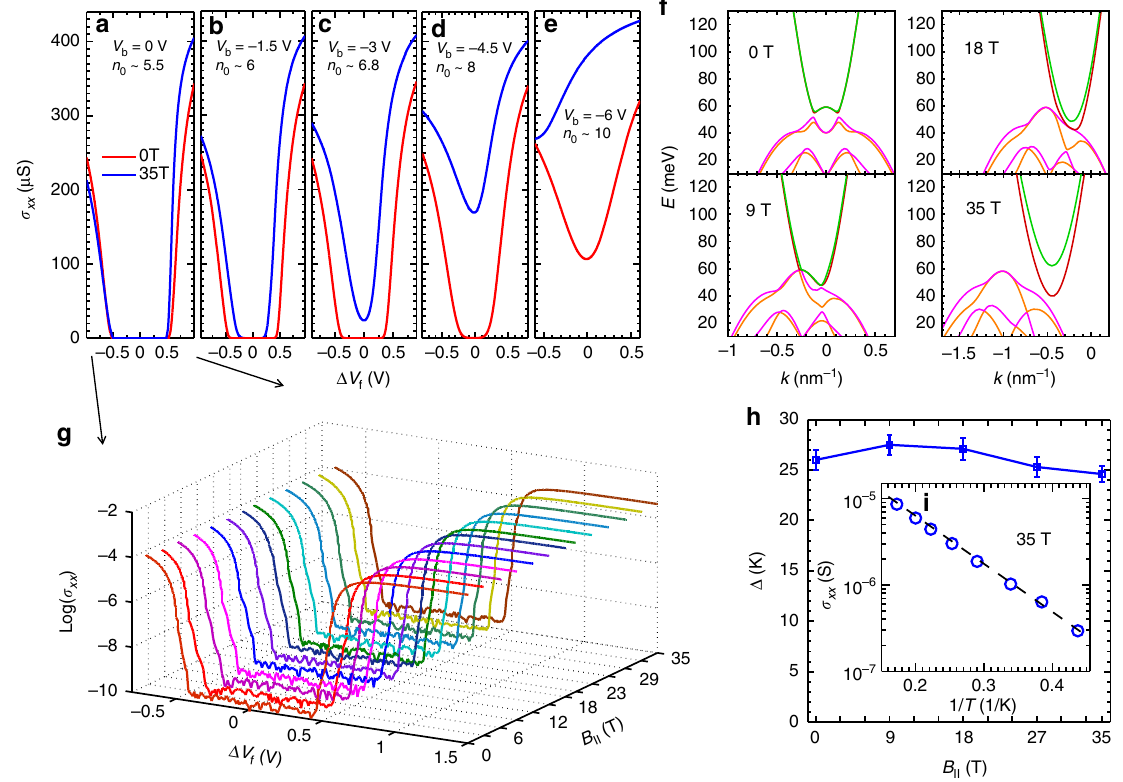
Fig. 4 Measurement of density-dependent hybridization gap under in-plane magnetic fi elds. a – e Front-gate bias voltage dependence of σ xx for a device at different back-gate bias voltages from 0 V to − 6 V at 30 mK, with a decrement of 1.5 V. In each panel, the value of n 0 is noted in units of 10 10 cm − 2 . The blue (red) lines are for B // = 35 T (0 T). f Energy dispersions calculated with an 8-band self-consistant model for tunneling electrons and holes with a typical inverted band at B // = 0 T, 9 T, 18 T, and 35 T. g Front-gate bias voltage dependence of σ xx for a Corbino device at zero back-gate at various B // from 0 T to 35 T measured at 30 mK. A zero-conductance dip appears and persists up to 35 T. h Gap energy Δ vs. B // at zero back-gate bias. The error bars come from the uncertainty in extraction of gap energy from Arrhenius plot. i Arrhenius plot of the dip conductance σ xx at 35 T for two orders of magnitude. Dashed line is a guide to the